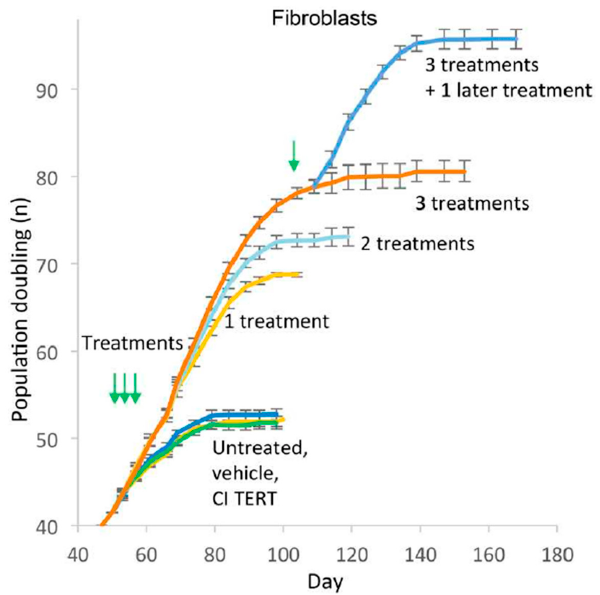
Figure 1. Growth curves of human fibroblasts treated once, twice or thrice in succession at 48 hours interval with human telomerase (TERT) mRNA, catalytically inactive (CI) TERT mRNA, or vehicle only, shows increase in population doubling [58]. Green arrows indicate the time of treatment.